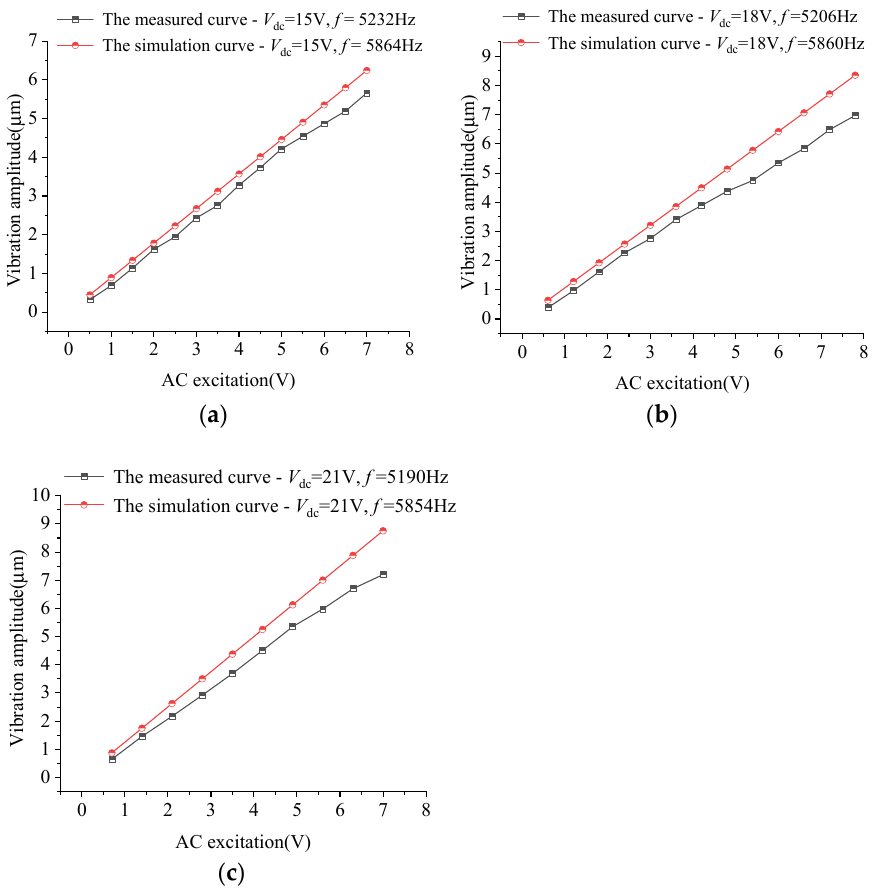
Figure 14. Comparison curves of the measured vibration amplitude of the MEMS sensor and the simulated value: (a) V dc = 15 V; (b) V dc = 18 V; (c) V dc = 21 V. Figure 10 in Section 3.1, where the comb-tooth damping changes with the movement displacement shows that the nonlinearity of the damping is related to the slope of the function. Therefore, the damping nonlinear strength of the mechanical vibration system ( S nonlinear ) is set as the damping difference between the resonator amplitude and the equilibrium point divided by the vibration amplitude, namely: